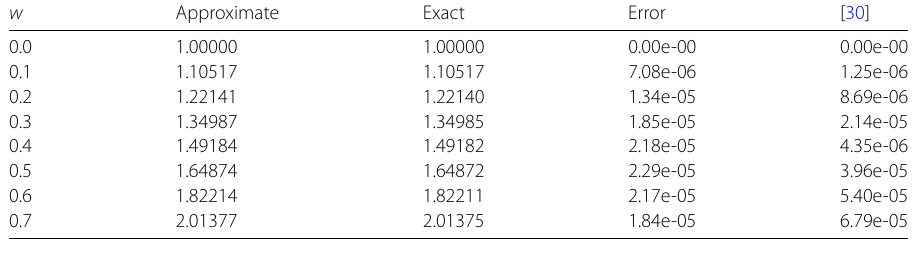
Table 2 Comparison of approximate and exact solution and absolute error of Example 5.2 when J = 4 w Approximate Exact Error [30] 0.0 1.00000